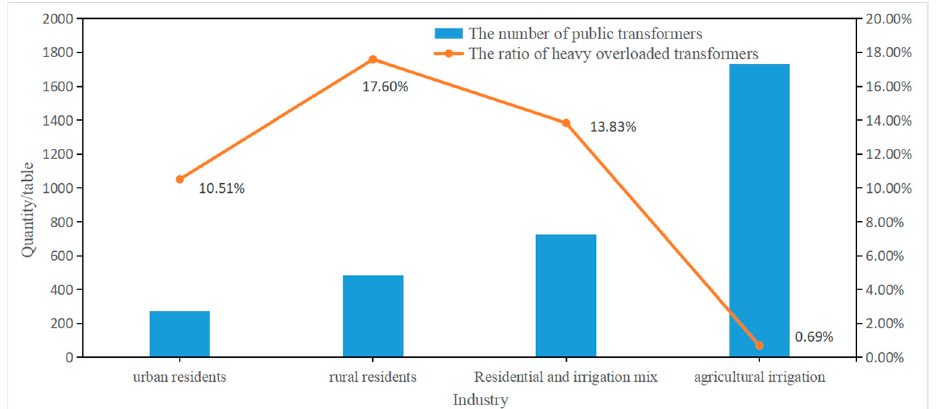
Figure 3. The ratio of the number of heavy overloads of public transformers in a specific period in a region according to the nature of the industry.